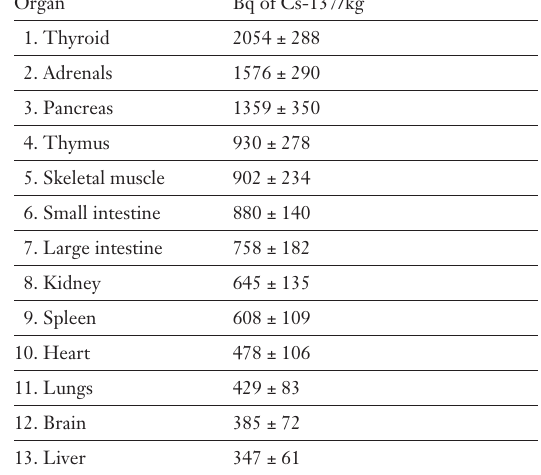
Organ Bq of Cs-137/kg